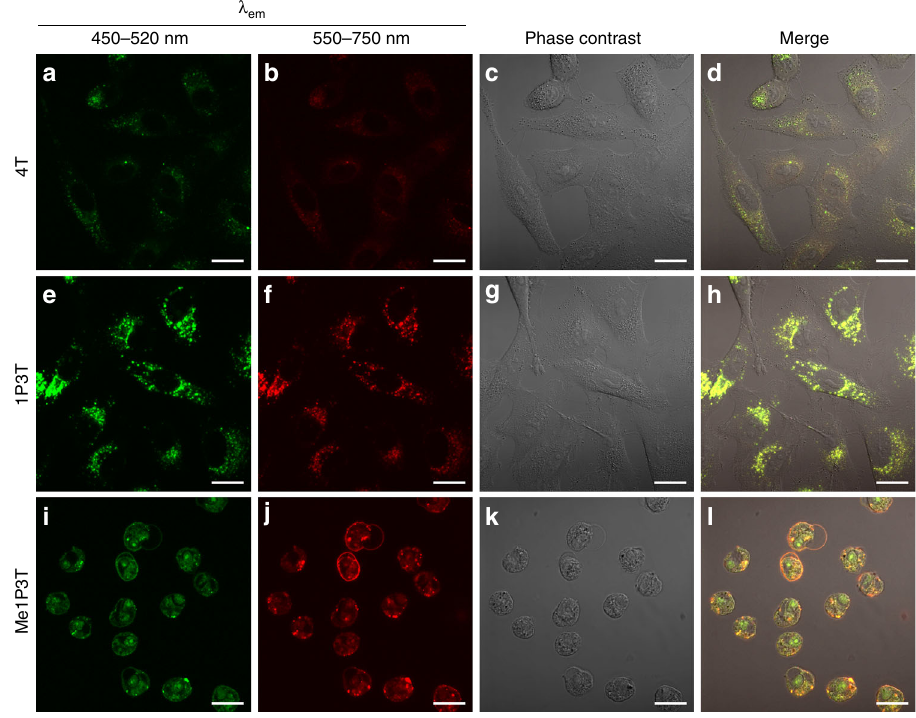
Fig. 4 Co-localized cellular uptake and morphologies of A549 cells with free oligothiophenes. Confocal laser scanning micrographs of A549 cells treated with 15 µ M oligothiophenes 4T a – d , 1P3T e – h , and Me1P3T i – l for 24 h at 37 °C, 5% CO 2 . All samples are excited at 405 nm, where the molecular states (450 – 520 nm, green) and the aggregated states (550 – 750 nm, red) of the oligothiophenes were visualized simultaneously. Co-existence of both aggregated and non-aggregated species was represented as yellow signals. Scale bar = 20 µ m. Poor cellular internalization was observed for 4T d , whereas co-localization of molecular and aggregated species were detected for 1P3T h . Signi fi cant cell rounding indicating cellular toxicity was observed for Me1P3T